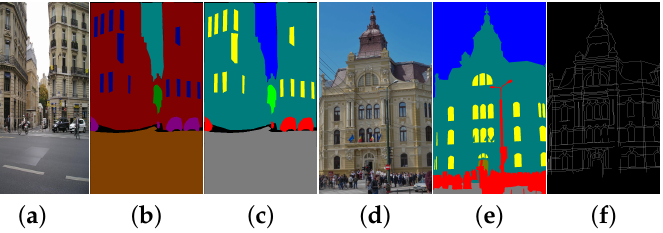
Figure 11. ( a ) Original LabelMe image resized; ( b ) LabelMe original labels; ( c ) LabelMe corelated labels; ( d ) TMBuD original image; ( e ) TMBuD label; ( f ) TMBuD edge ground truth.